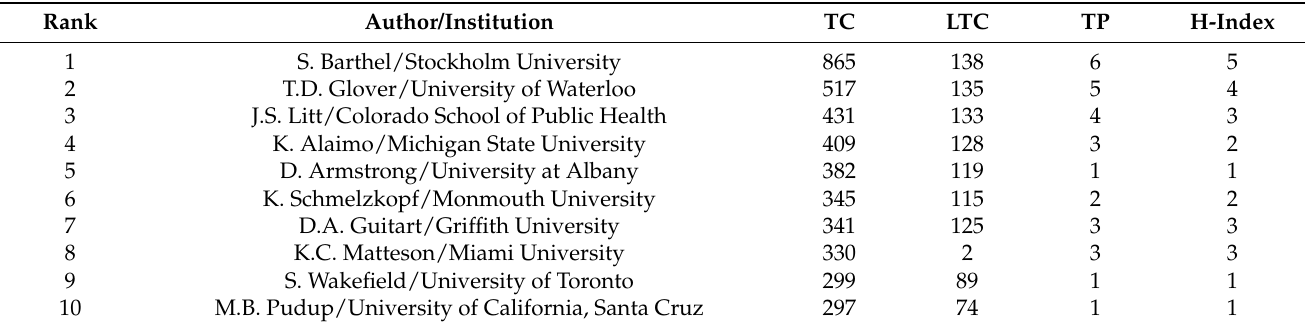
Table 5. The ten representative authors contributing to community gardens research based on global total citations (TC) from 1995 to